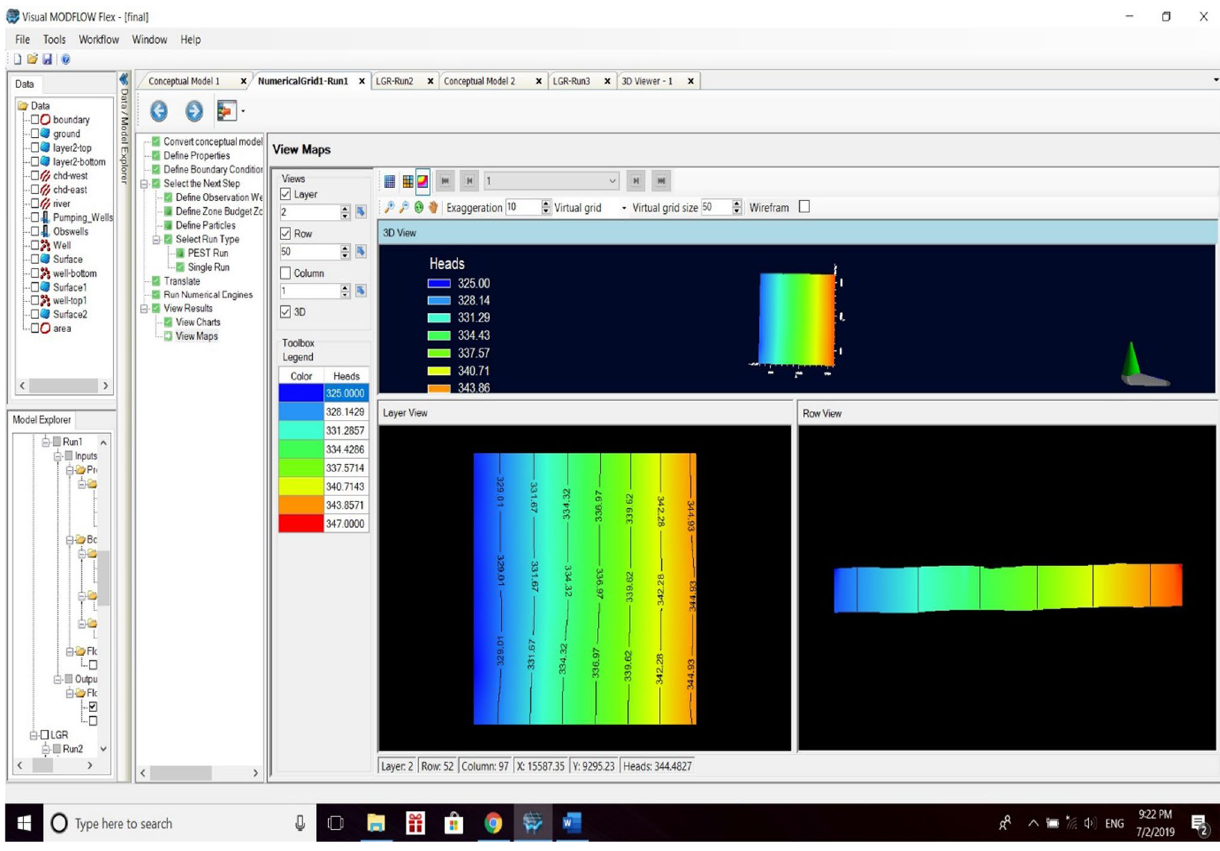
Fig. 14 Groundwater level head simulation of Layer-2 using numerical